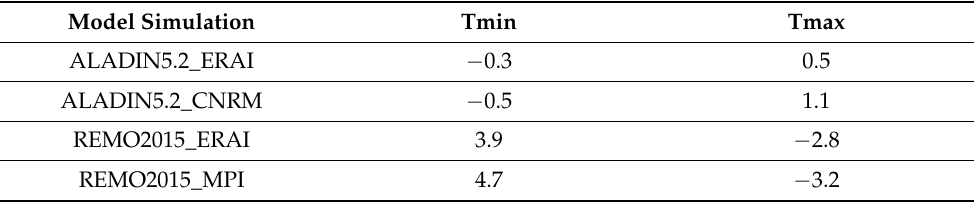
Figure 5. Annual mean values of summer days, hot days and frost days for 1981–2000 based on the CarpatClim-HU observation dataset ( x -axis) and the RCM simulations ( y -axis). Each dot represents the value of one grid point over Hungary. Table 5. Annual minimum and maximum temperature bias ( ◦ C) of the four RCM simulations over Hungary in comparison with the CarpatClim-HU observation dataset. Period: